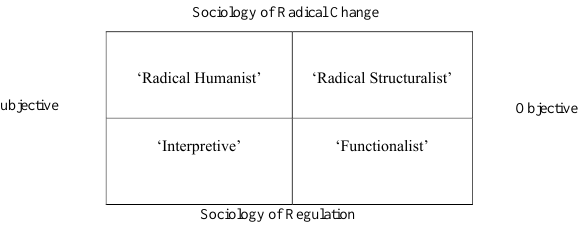
Figure 1: Burrell and Morgan’s (1979:22) four paradigms for analysis of social theory Ontological assumptions: Nominalism versus Realism